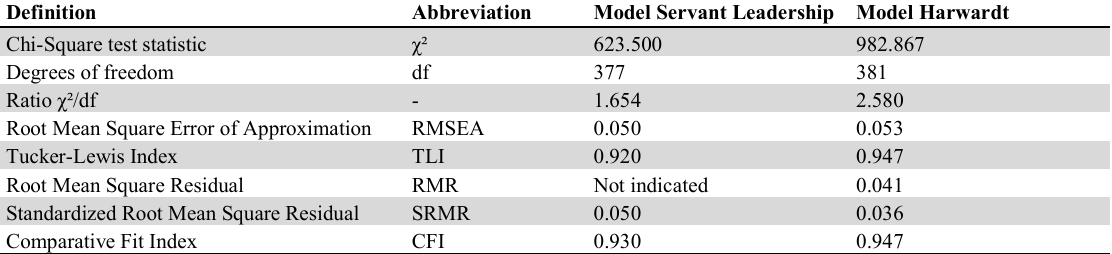
Quality criteria of the